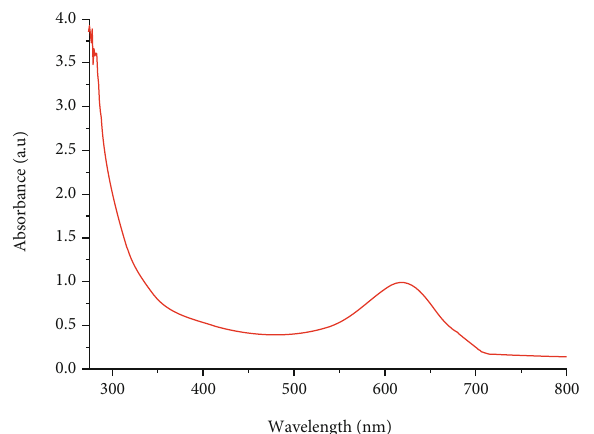
Figure 8: Absorbance spectrum of natural dye of extracted rose myrtle ( Rhodomyrtus tomentosa ).